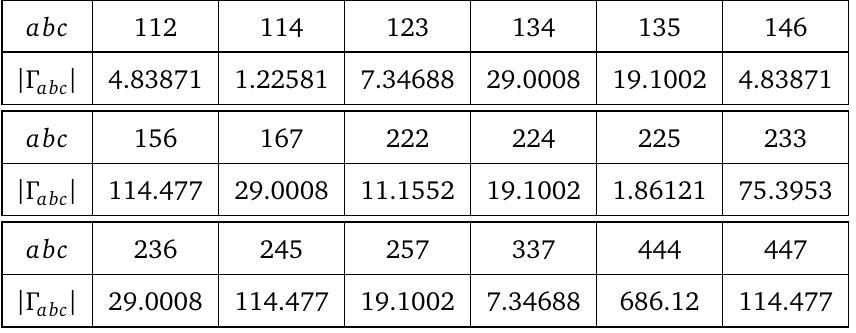
coming from the simple poles of the S -matrix abc